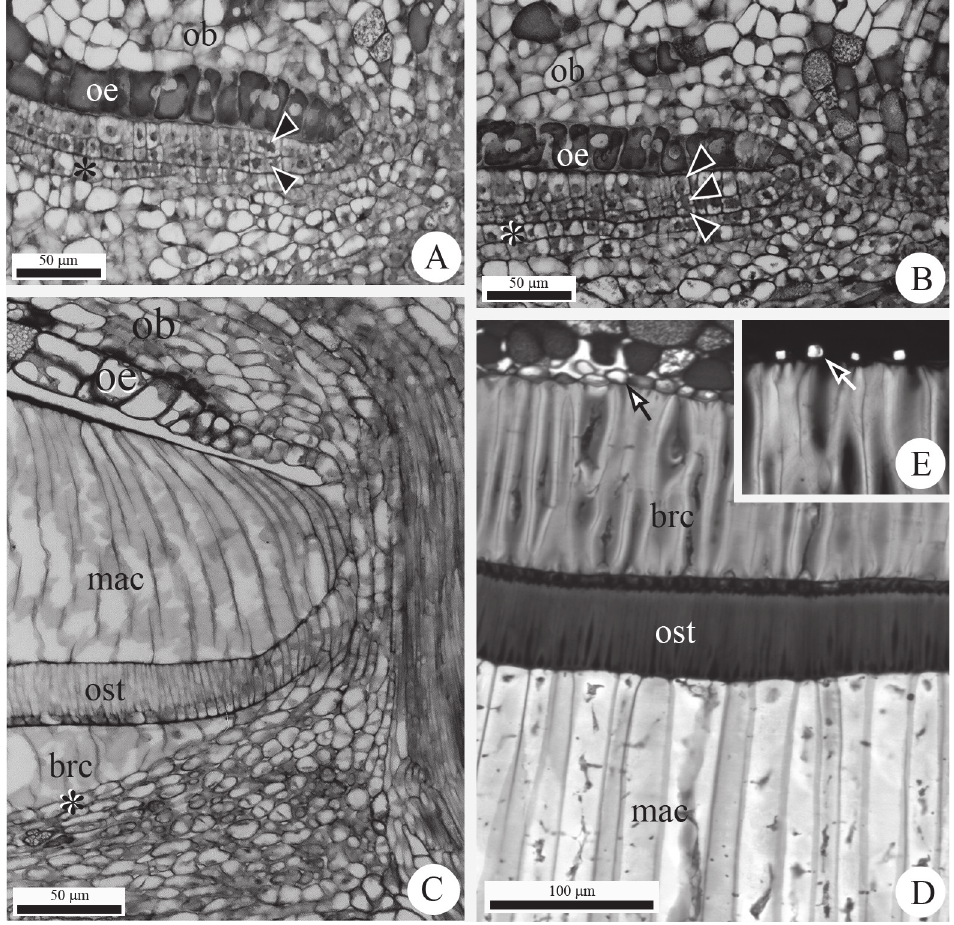
Fig. 2 - Anatomy of flowers and fruits of Lithraea brasiliensis Marchand. A. Endocarp with two cell layers (arrowheads). B. Endocarp with three cell layers (arrowheads). C. Intermediate stage of endocarp development. D. Detail of the endocarp and crystalliferous layer (arrow) in ripe fruits. E. Detail of crystalliferous layer, shown in D , after polarized light. Crystal indicated by the arrow. Crystalliferous layer (asterisk). ob = funicular obturator; oe = ovular epidermis; mac = macrosclereids; ost = osteosclereids; brc =